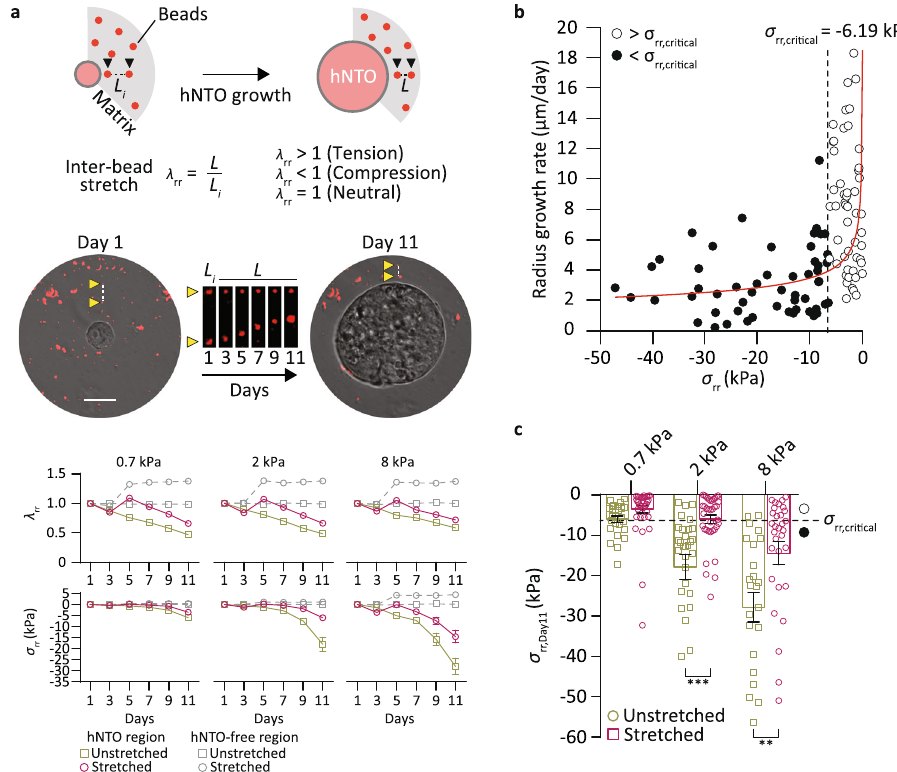
Fig. 3 Matrix actuation modulates mechanical microenvironment by relieving growth-induced compression. a Schematic representation of bead tracking technique and corresponding representative images (yellow arrows point to a representative red fl uorescent bead pair) where λ rr is the interbead stretch and L and L i denote the interbead distance and initial interbead distance, respectively. Quanti fi cation of matrix radial stretch and stress for soft, intermediate and stiff matrix conditions (analysis of 10 approximately equally distributed segments per organoid for a total of 30 segments per datapoint). b hNTO radius growth rates at day 11 and corresponding matrix compressive stress states. Red curve represents best fi t power curve (y = 51.4( − x) − 0.291 , R 2 = 0.2215) where knee point σ rr,critical = − 6.19 kPa, with fast growth rate regime σ rr > σ rr,critical (open circles) and slow growth rate regime for σ rr < σ rr,critical (black circles). c Compressive stress states for different stiffnesses at day 11 (data from a , statistical analysis was determined by unpaired two-sided t -test with Welch ’ s correction (2 kPa p = 0.0006, 8 kPa p = 0.0063)). Error bars are SEM, scalebar 25 μ